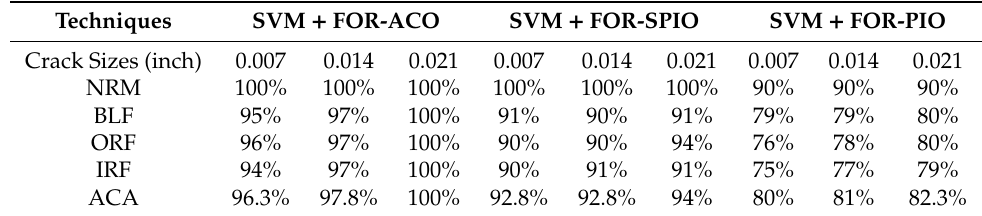
Table 8. The Accuracy of Single-Type Fault Identification When the Torque Load is 3-hp.